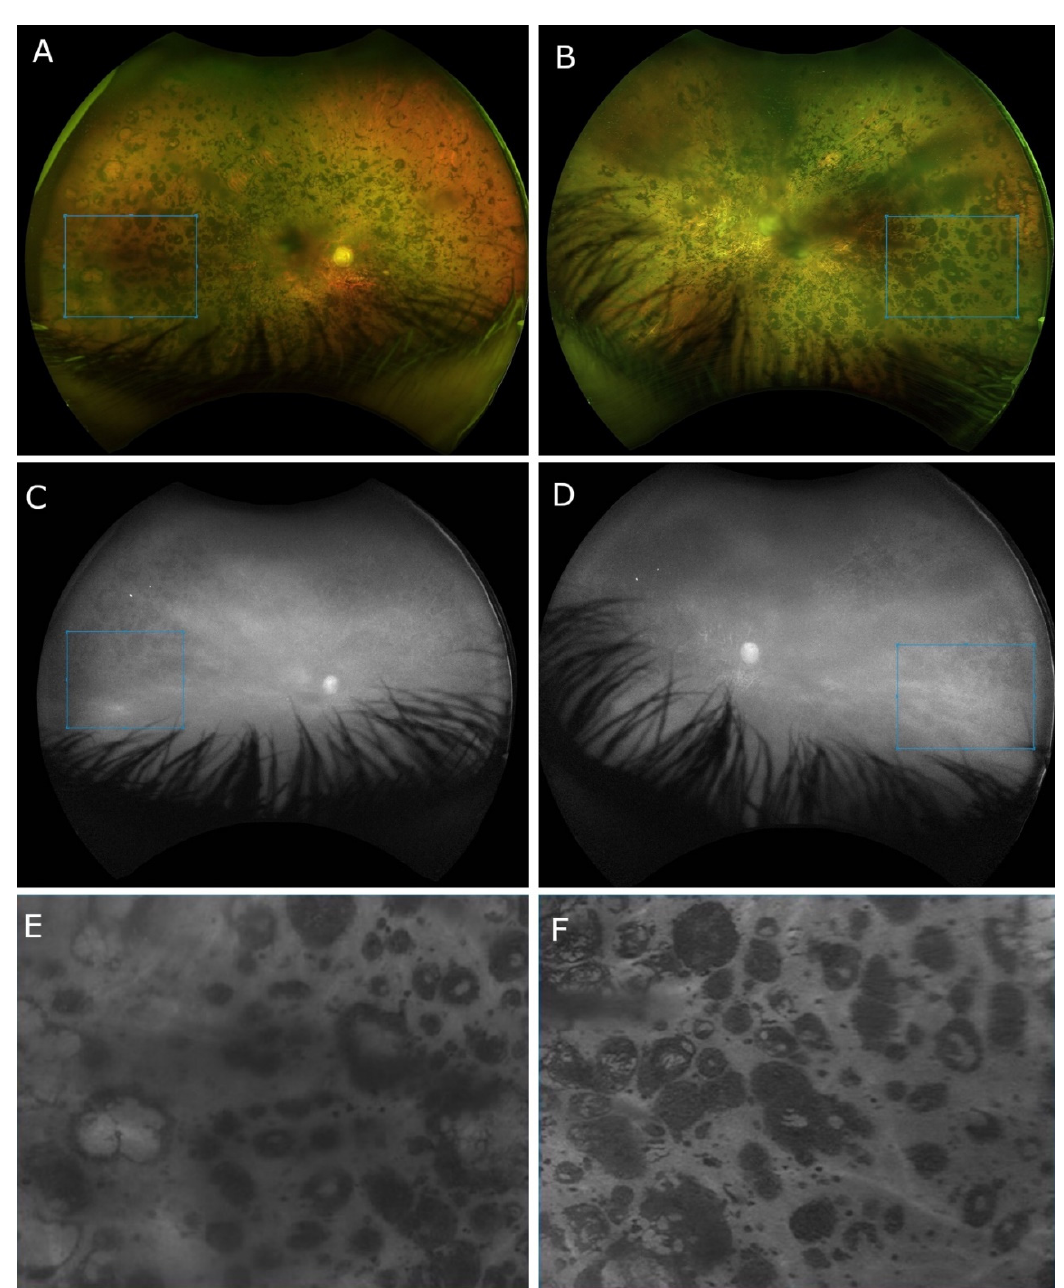
Figure 2. Ultra-widefield (UWF) 200 ° fundus photos of the right eye ( A ) and left eye ( B ) showing nummular pigment clumping of variable sizes. Retinal vessels are presented as solid strands of hyaline-like connective tissue with avascular mid- and peripheral retina. Short-wavelength fundus autofluorescence (Optos ® California) UWF 200 ° photos of the right eye ( C ) and left eye ( D ) depicting the absence of autofluorescence. Chorioretinal atrophy revealed the hyperautofluorescent attributes of the sclera. Enlarged image of the areas (marked with the blue squares in ( A – D )) with nummular pigment clumping on RE ( E ) and LE ( F ) obtained with a 100% red blend and 4.35× magnification.